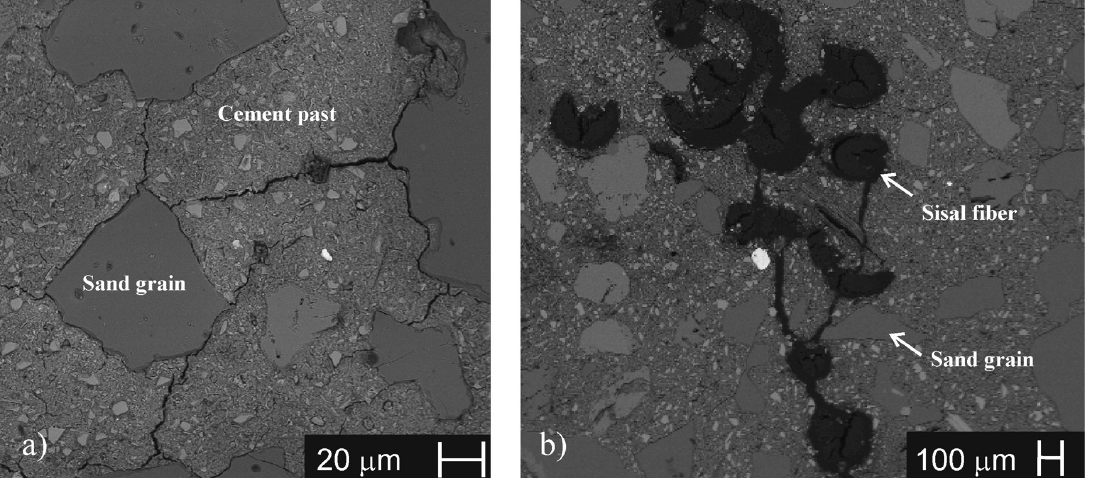
Figure 4. SEM of internal cracking: a) matrix; b) composite 10 .